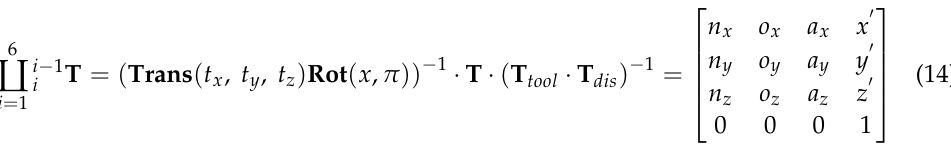
Figure 14. The axes of the UR5 robot. Equation (14) determines the pose of the end-effector of the UR5